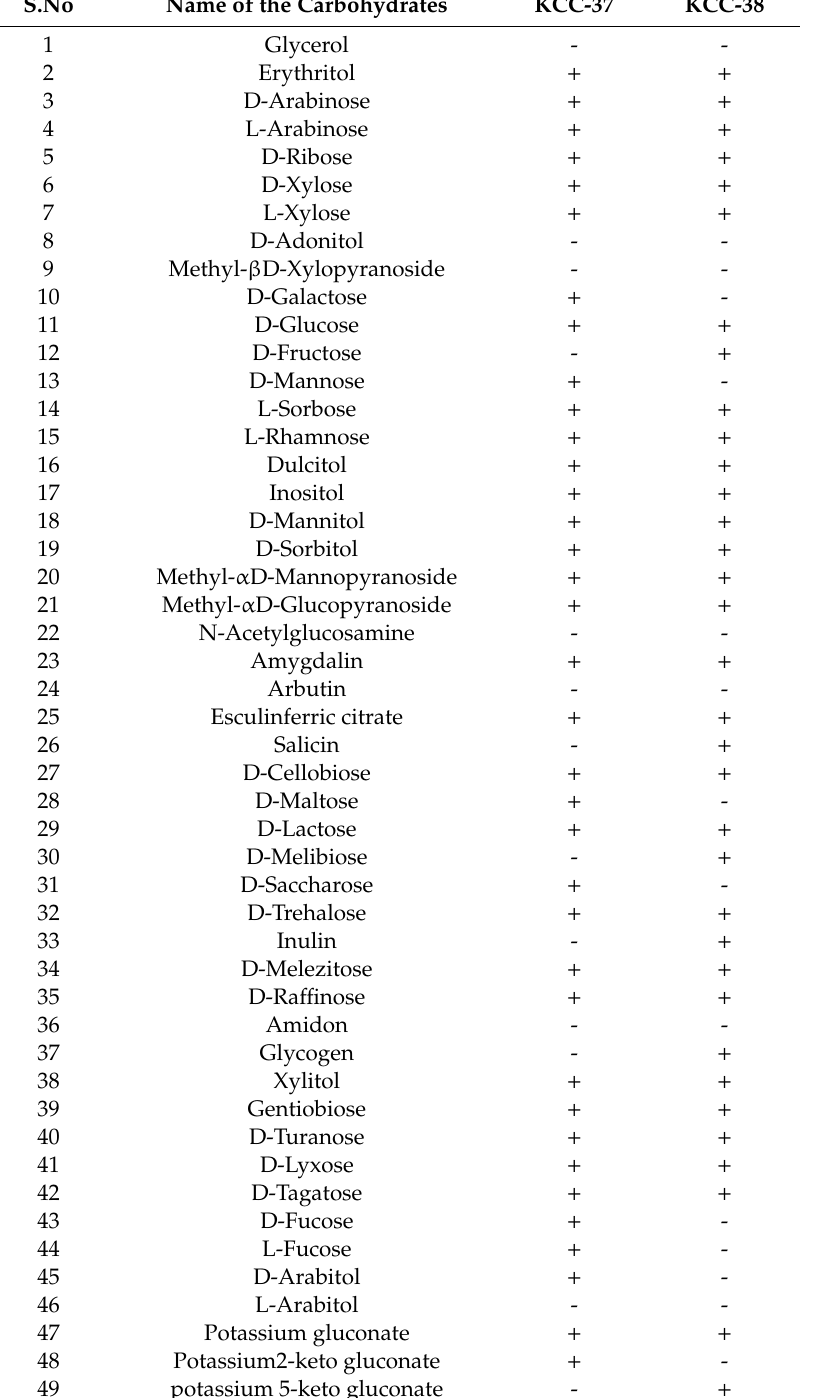
Table 1. KCC-37 and KCC-38 e ffi ciencies on fermentation of di ff erent